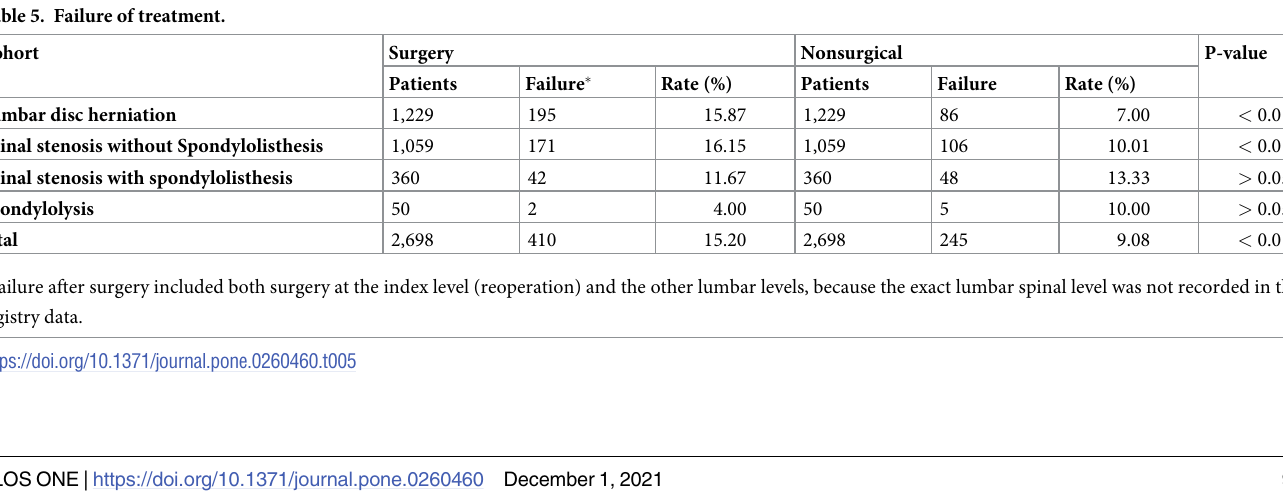
interventions in patients with spinal stenosis with and without spondylolisthesis [22, 30]. Daf- finer S et al. analyzed the costs for 30,709 patients with LDH who received nonsurgical care before ultimately undergoing surgery by using a health insurance database [20]. During the preoperative 3 months, $105,799,925 was spent for nonsurgical treatment ($3,445/patient), and the nonsurgical intervention accounted for 32% of the cost. Considering that the cost of surgery was $7,841, the total cost could have been reduced by early surgery [20]. The costs and clinical outcomes were considered together in a cost-effectiveness analysis [23]. Tosteson AN et al. summarized the cost-effectiveness of surgery: surgery improved quality of life to a greater extent than nonsurgical treatment, and the cost per QALY (quality-adjusted life year) was nosis without spondylolisthesis, and $64,300 (95% CI: $32,864, $83,117) for spinal stenosis with spondylolisthesis at 4 years [21]. Based on these results, early surgery is recommended as a cost-effective option [20]. Those estimates were based on medical costs, and they would be higher if indirect costs, 75% of which can be attributed to the costs for low back pain, had been considered simultaneously [31]. However, the recommendation was made on the basis of the high costs of nonsurgical medical services. The present results showed that the cost of surgery